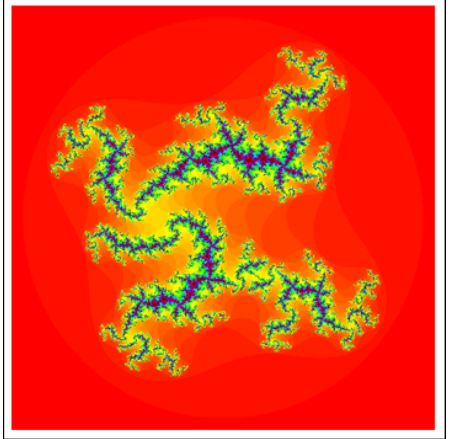
Figure 9. J-set via F-iteration with image visual time = 51.28 s.